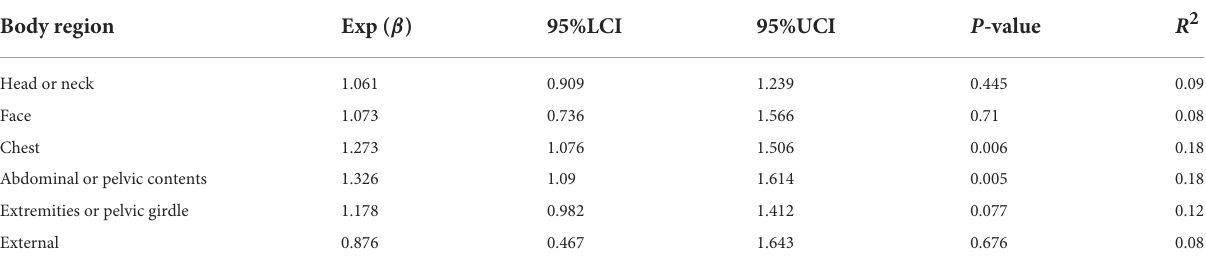
TABLE 3 Linear regression between serum SDC-1 and six body regions defined in the AIS used to calculate the ISS score in trauma patients on arrival at the ER. Body